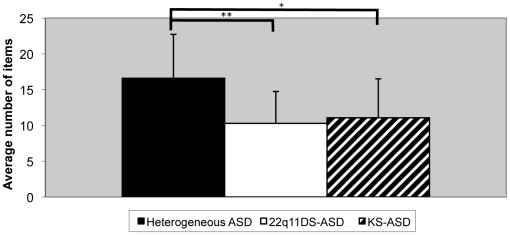
Mean number of ADI-R items reaching autistic criterion (ADI-R score  =  2).* P<0.002, ** P<0.0001, univariate analysis of variance.